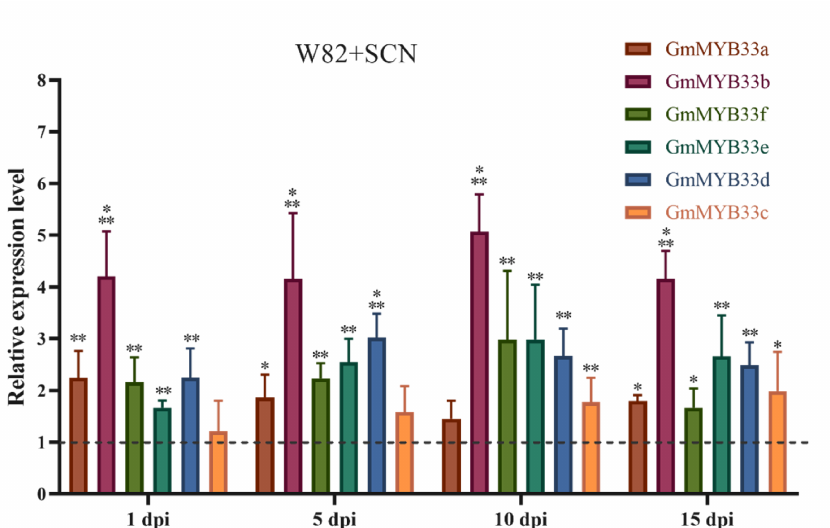
Figure 3. Soybean GmMYB33 genes were upregulated during the soybean parasite by H. glycines . dpi, day post inoculation. Expression levels of GmMYB33 in W82-innoculated SCN were relative to W82 control. Gmubi-3 was used as internal reference gene. Error bars represent the standard deviation from the means. t -test was applied to compare the differences of expression level between W82 control and W82 inoculated with SCN at each time point. SCN, soybean cyst nematode. *, ** and ***, significant difference found at p < 0.05, p < 0.01 and p < 0.001